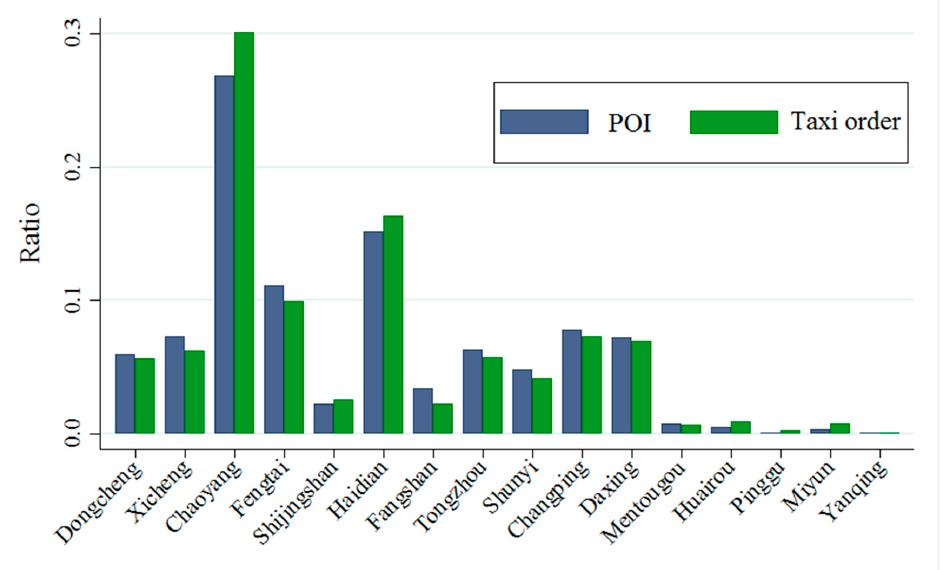
Figure 1. Distribution of POIs and taxi orders in different regions.